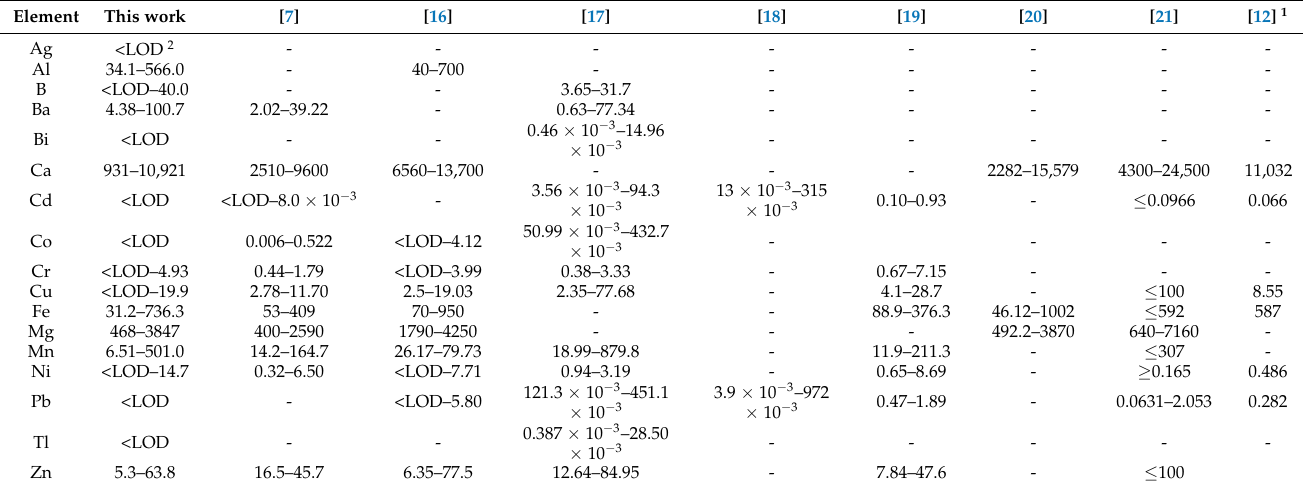
Table 4. Comparison of the elemental composition of spices found in this study with reported com- position of other studies.